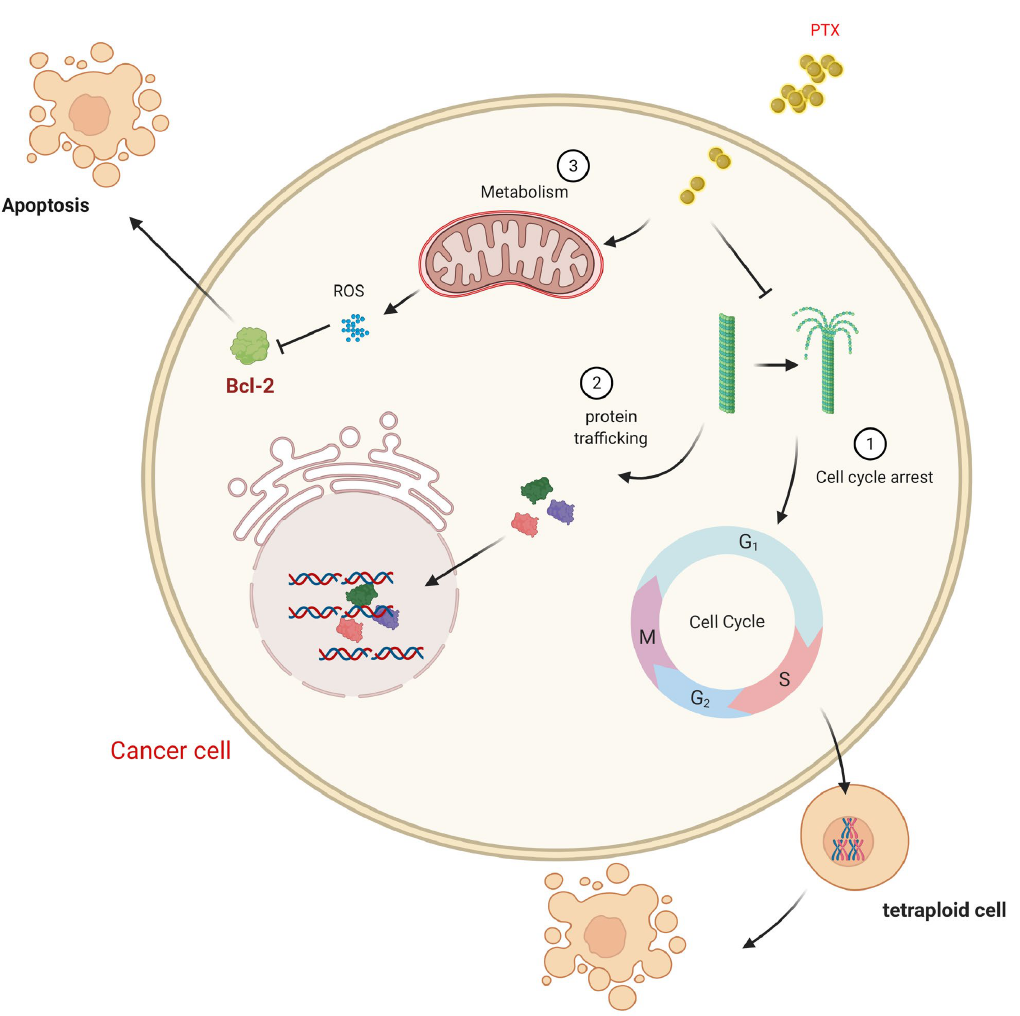
Figure 3. The mechanisms of PTX cytotoxicity in the cell. PTX can act through different mechanisms. After entering the cell, PTX can act as an antimicrotubular agent, leading to two actions: (1) cell cycle arrest, producing tetraploid cells containing 4×, in which unstable tetraploid cells undergo cell death; (2) disbalanced microtubule formation affects the protein traffic into the nucleus, especially the transcription factors necessary for cell survival or proliferation. PTX can also affect metabolism in mitochondria, elevating ROS levels, which inhibits Bcl-2 inducing apoptosis.